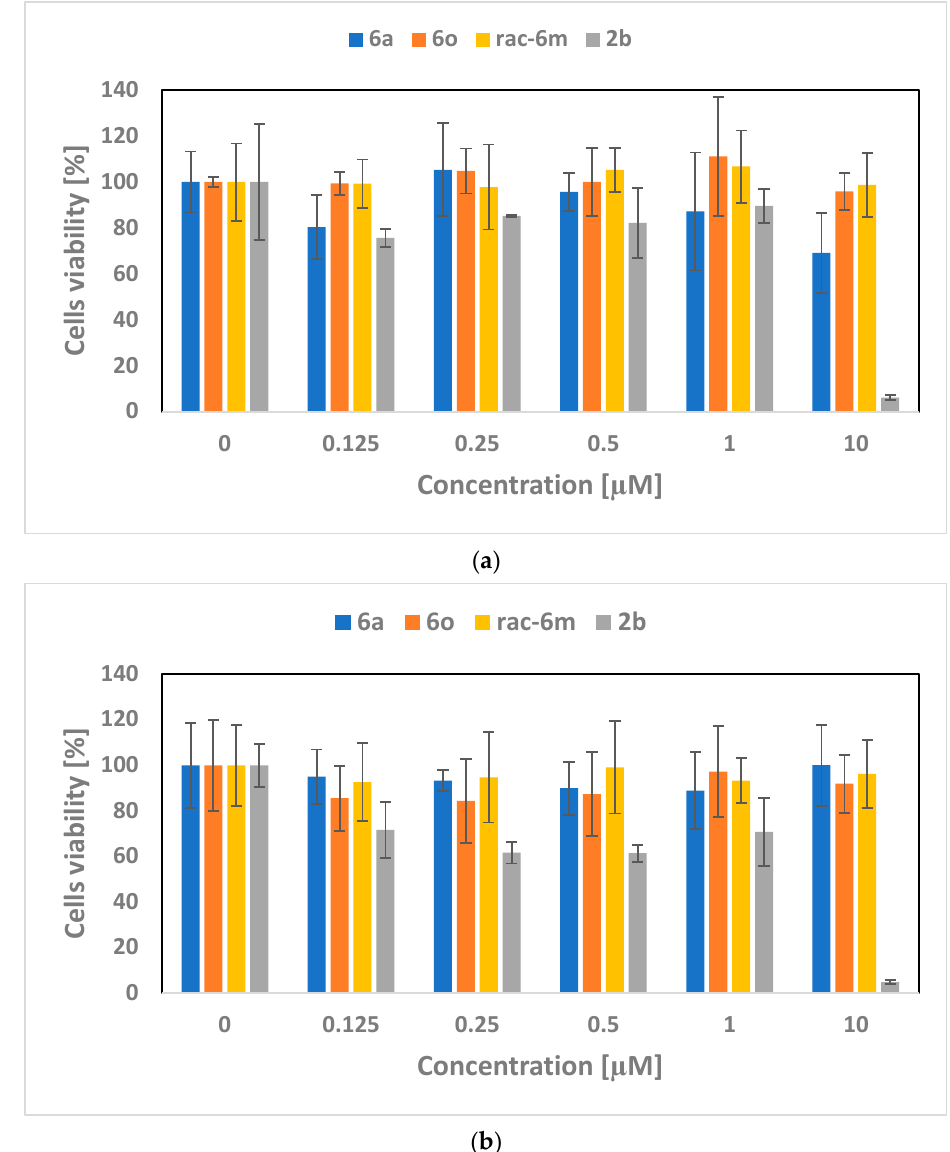
Figure 2. Porphyrin cytotoxicity tests on the cell line: ( a ) A375, ( b ) HaCaT.